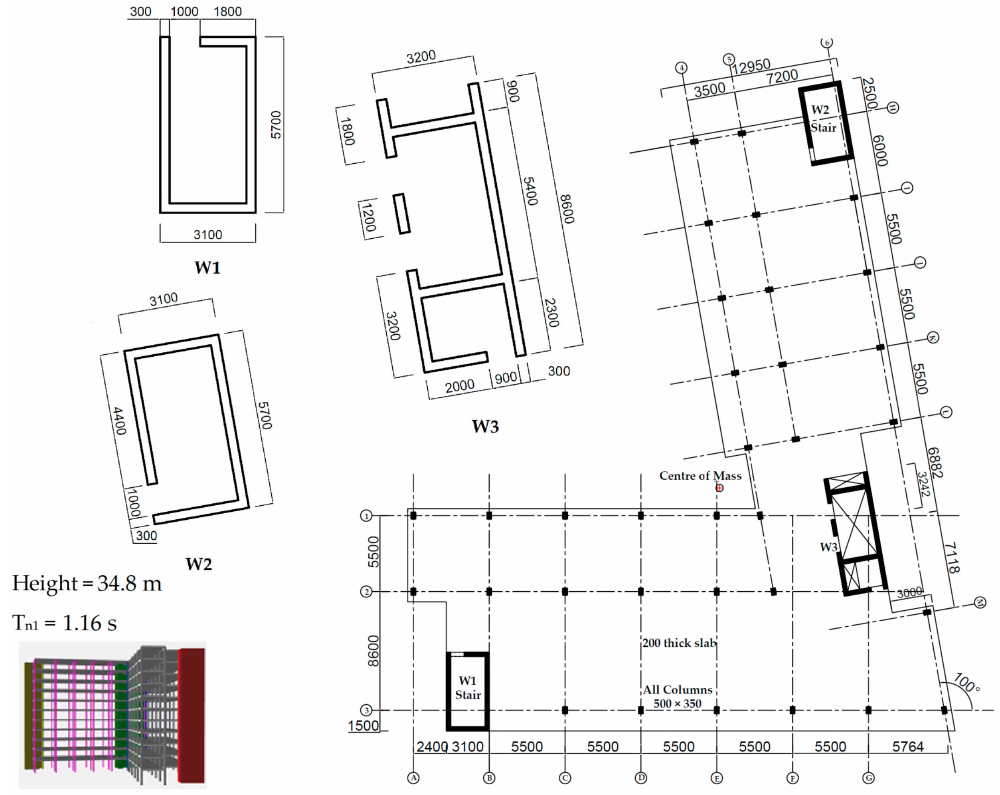
Figure 11. Floor plan, structural layout, and elevation view of CSB 1 (all dimensions are in mm)